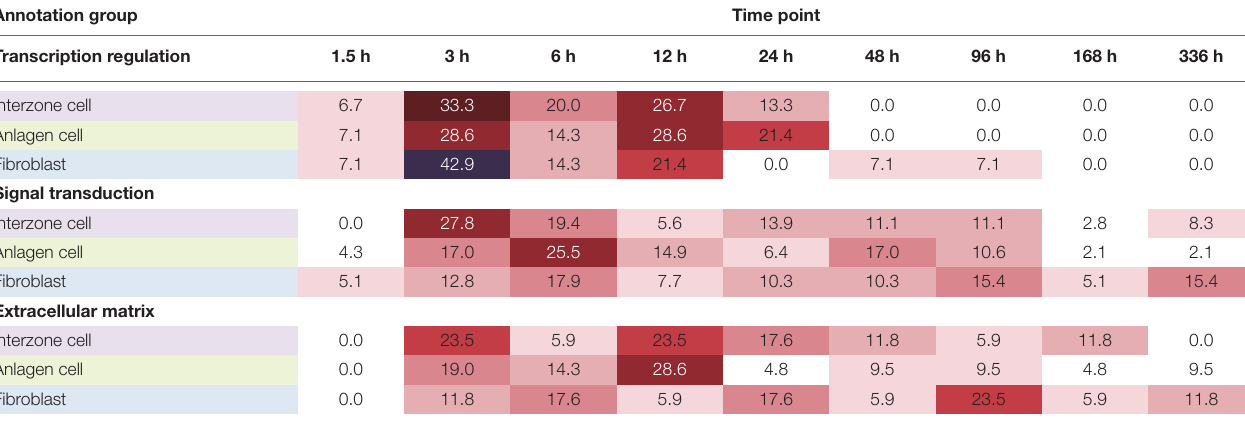
TABLE 1 | Timing of the first response to the chondrogenic induction protocol within functional annotation group in each cell type (% of gene loci with significant changes). Annotation